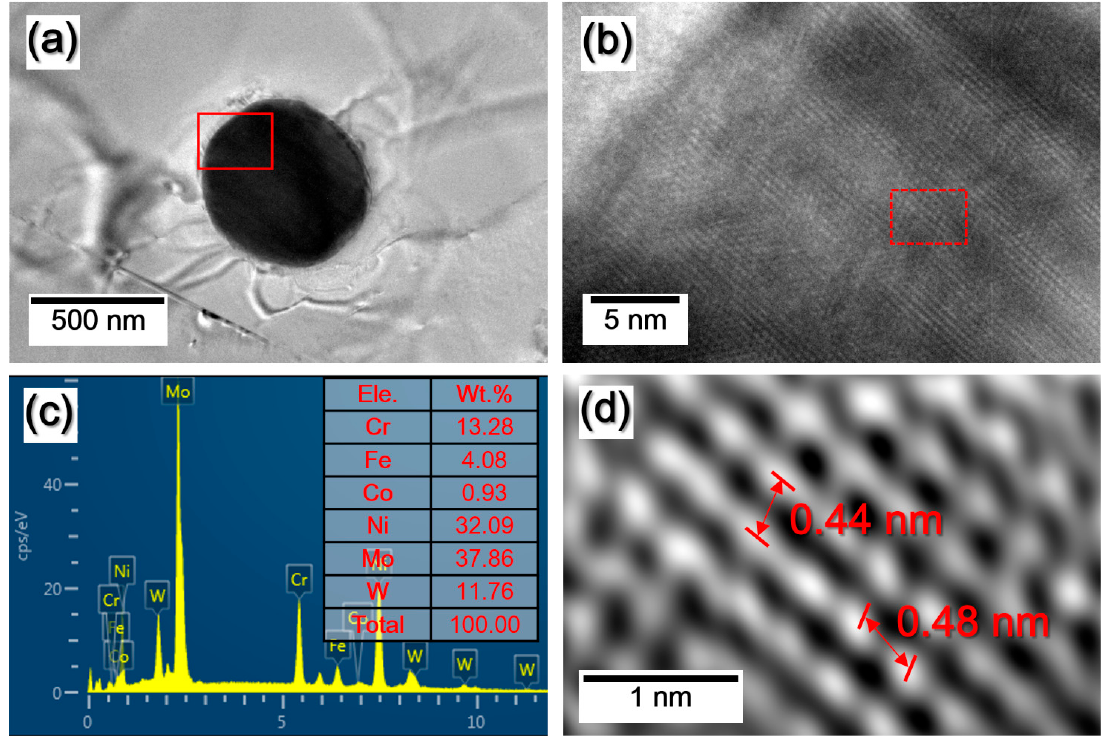
Figure 6. The closer observation of a precipitate particle: ( a ) TEM image, ( b ) high-magnification image of the square in ( a ), ( c ) EDS analysis of the precipitate, ( d ) high-resolution image of the square in ( b ) after inverse Fourier transform.